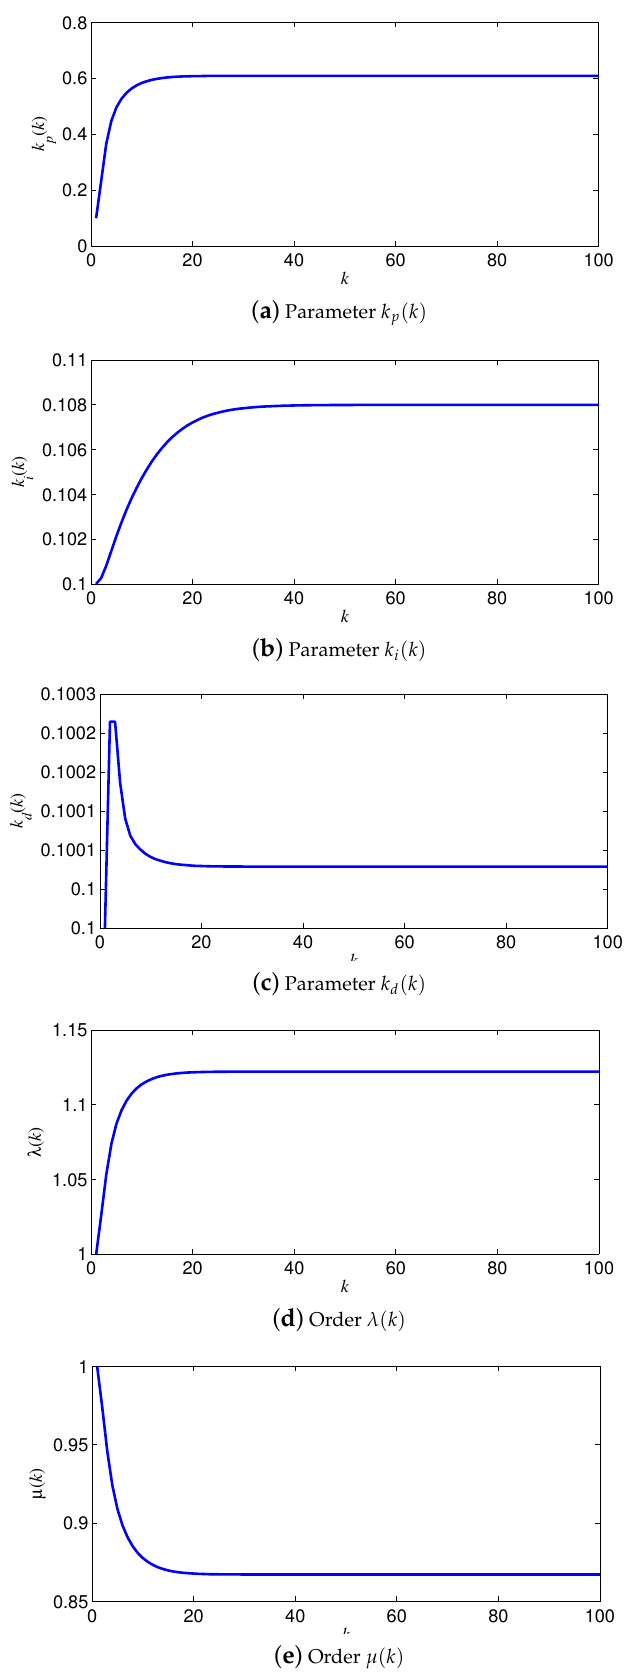
Figure 8. Parameters and